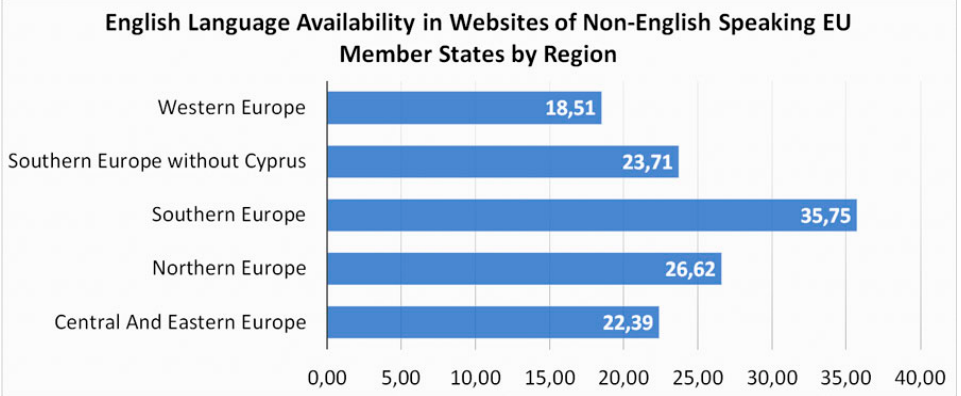
Figure 12. English Language Availability in Websites of Non-English speaking EU Member states by region.